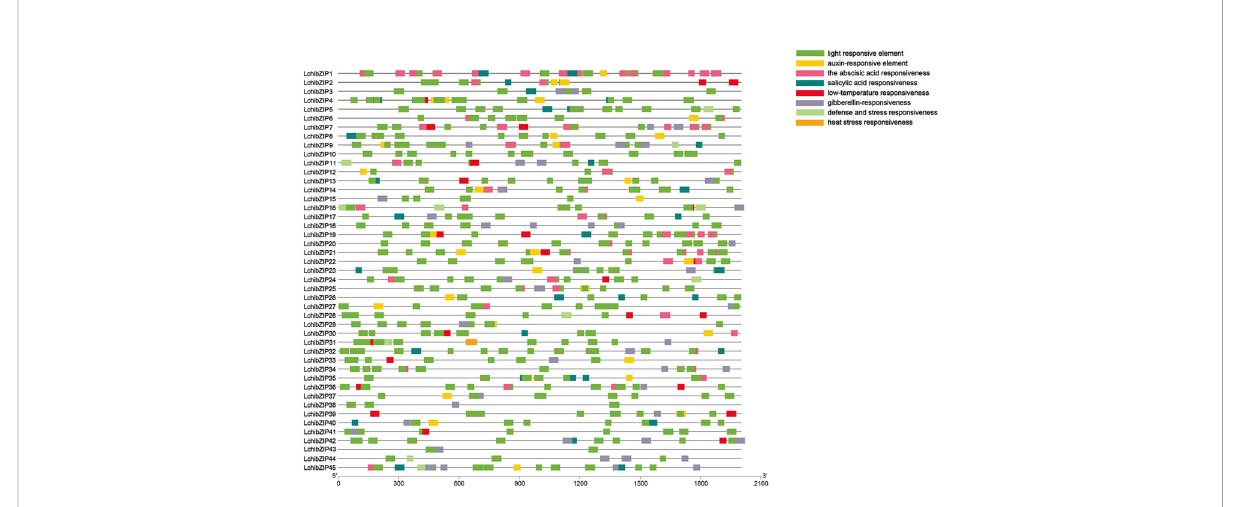
FIGURE 7 Cis-Acting element analysis of L.chinense bZIP gene